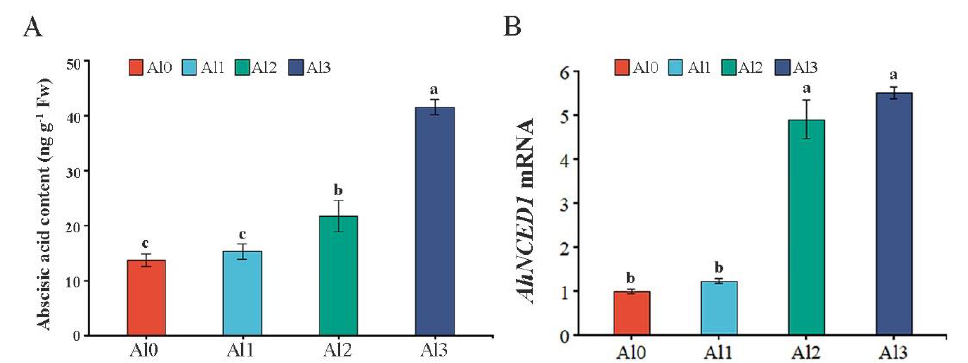
Figure 5. Effect of different Al 3+ concentrations on the ABA content and AhNCED1 transcript levels. The effect of Al treatments on ABA content ( A ). qRT-PCR analysis of relative transcription levels of AhNCED1 ( B ). Al0, Al1, Al2, and Al3 represent 0 (pH 6.85), 1.25 (pH 4.03), 2.5 (pH 3.85), and 5 (pH 3.69) mmol/L AlCl 3 .18H 2 O solutions, respectively. Data are means (±SE), n = 3. Marking the same letters means p ≥ 0.05 (LSD), there is no significant difference, the difference between different letters means p < 0.05 (LSD), and the difference is significant.